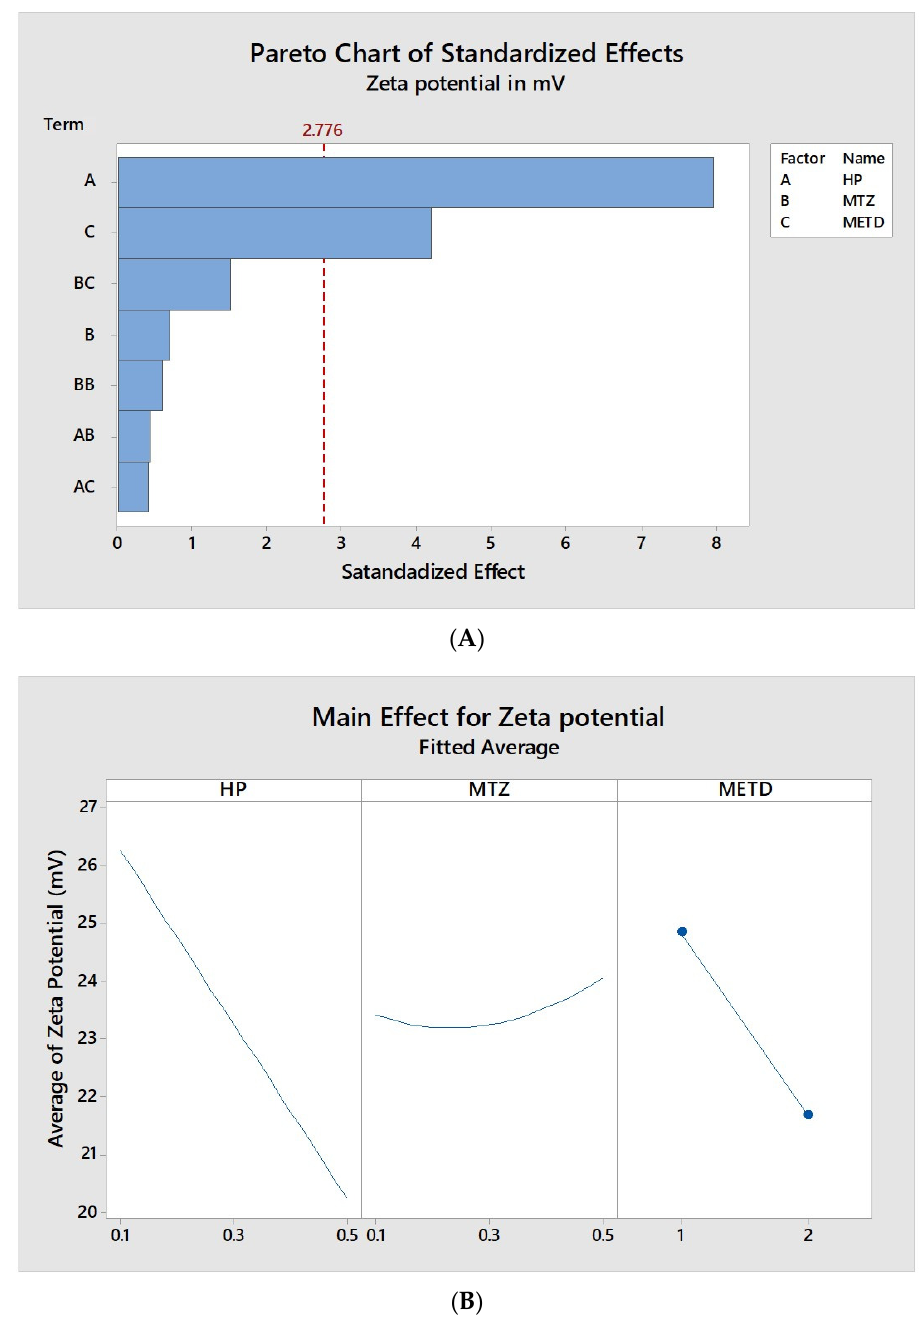
Figure 3. Graphic representation of factor influences on average PDI of particles. ( A ) Standardized Pareto chart estimating the e ff ect of mass ratio HP, mass ratio MT, method, and their interaction on the PDI of the particles. The red dashed vertical line represents the 0.05 critical value for ANOVA. All bars extending to the right of this line indicate that the e ff ects are statistically significant at 5% significance level. ( B ) Isolated analysis of the factors, HP / MT concentration, and method (on X -axis), and their influence on the PDI of the nanoparticles (on Y-axis).